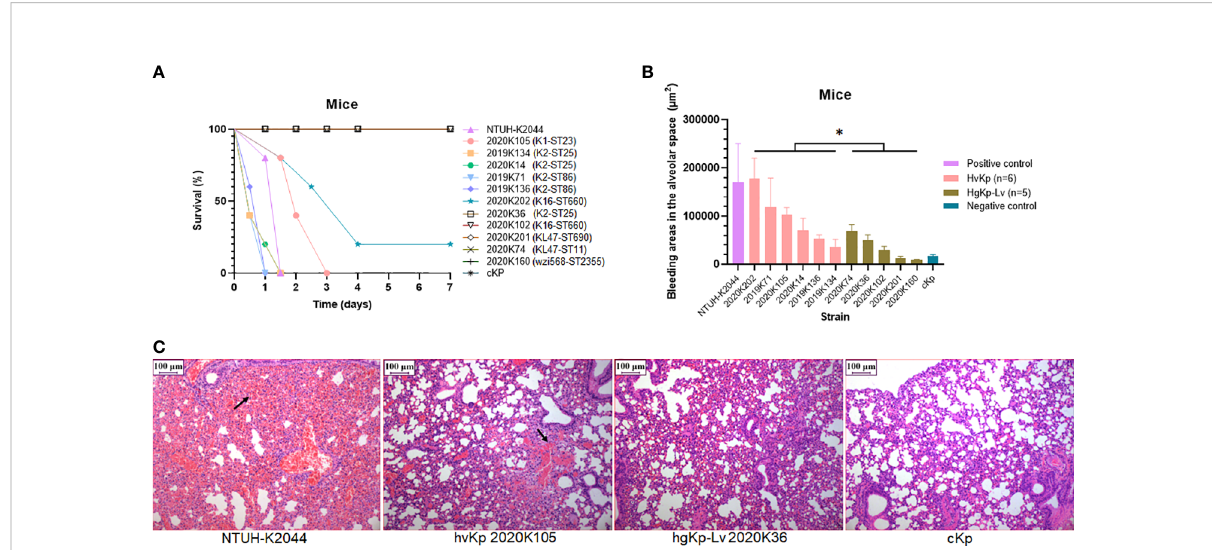
FIGURE 3 Veri fi cation of virulence phenotypes in murine sepsis model using selected hvKp (n = 6) and hgKp-Lv (n = 5) isolates with high-risk clones. (A) Mouse survival curves for NTUH-K2044 (hypervirulence control), hvKp isolates (K1-ST23 2020K105, K2-ST25 2019K134, K2-ST25 2020K14, K2-ST86 2019K71, K2-ST86 2019K136, and K16-ST660 2020K202), hgKp-Lv isolates (K2-ST25 2020K36, K16-ST660 2020K102, KL47-ST690 2020K201, KL47-ST11 2020K74, and wzi568-ST2355 2020K160), and cKp (low virulence control). The log-rank (Mantel – Cox) test was performed to assess the indicated curves. A signi fi cant difference ( c 2 = 6.9078, P = 0.0086) was observed between the hvKp and hgKp-Lv groups. (B) Areas of bleeding in the alveolar space in infected mice. A signi fi cant difference (t = 2.33, P = 0.0446) was observed between the hvKp and hgKp-Lv groups, according to independent- samples t-test analysis. P < 0.05 (*). (C) Histological changes in lungs of infected mice. From left to right, images show mouse lungs infected with NTUH-K2044, hvKp 2020K105, hgKp-Lv 2020K36, and cKp,